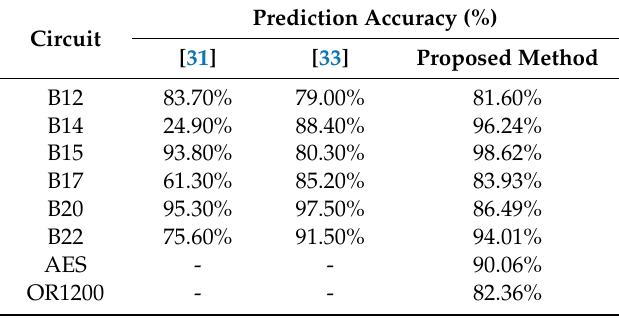
Table 5. Accuracy of scan-chain diagnosis for SA0 faults occurring in the first scan chain.